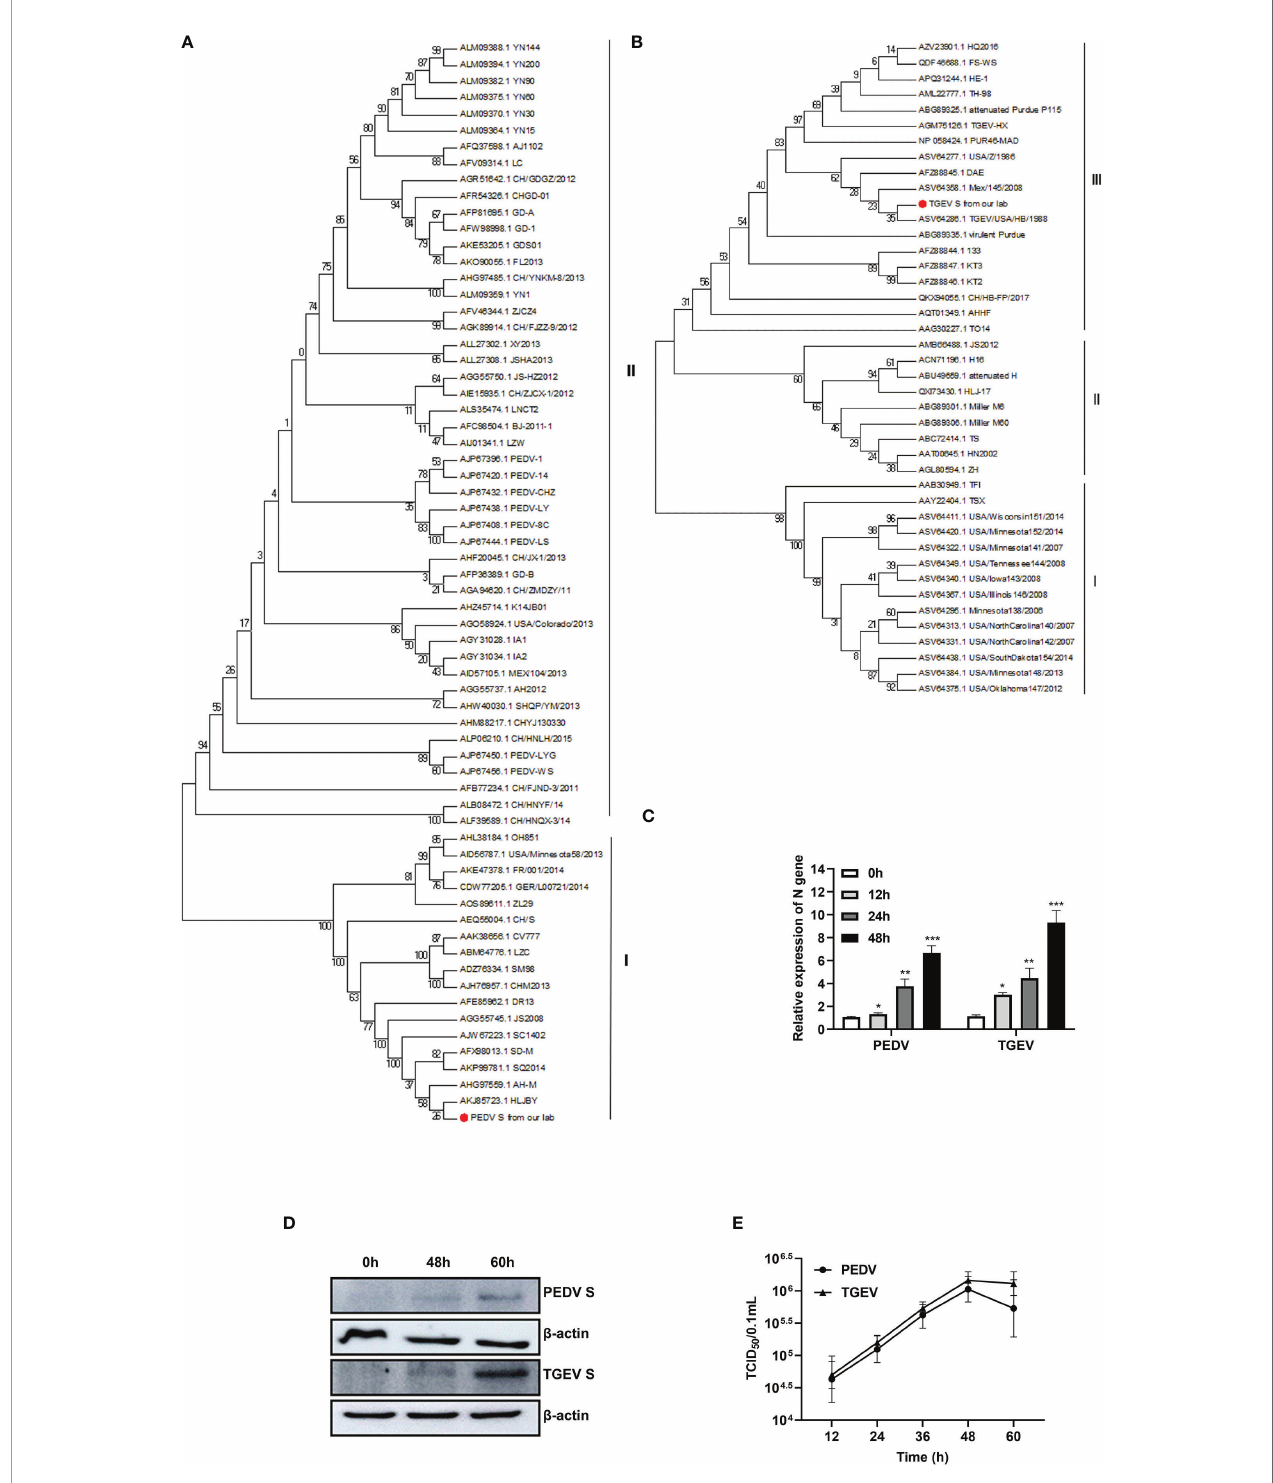
FIGURE 1 | Phylogenetic analysis and proliferation kinetics of PEDV and TGEV in IPEC-J2 cells. (A) Phylogenetic trees of PEDV based on the S gene. (B) Phylogenetic trees of TGEV based on the S gene. (C) qPCR analysis of PEDV and TGEV infection in IPEC-J2 cells. IPEC-J2 cells were infected (MOI = 1) of PEDV or TGEV. The cells were collected at 0, 12, 24, 36, and 48 hpi respectively, followed by RT-PCR analysis. *, p-value <0.05; **, p-value <0.01; ***, p-value <0.001. (D) Western blot analysis of PEDV and TGEV replication in IPEC-J2 cells at 48 and 60 hpi. Unprocessed original images is found in Supplementary Figure S1 . (E) One-step growth curve of PEDV and TGEV in Vero or ST cells, respectively. Viruses were collected from IPEC-J2 cells, followed by TCID 50